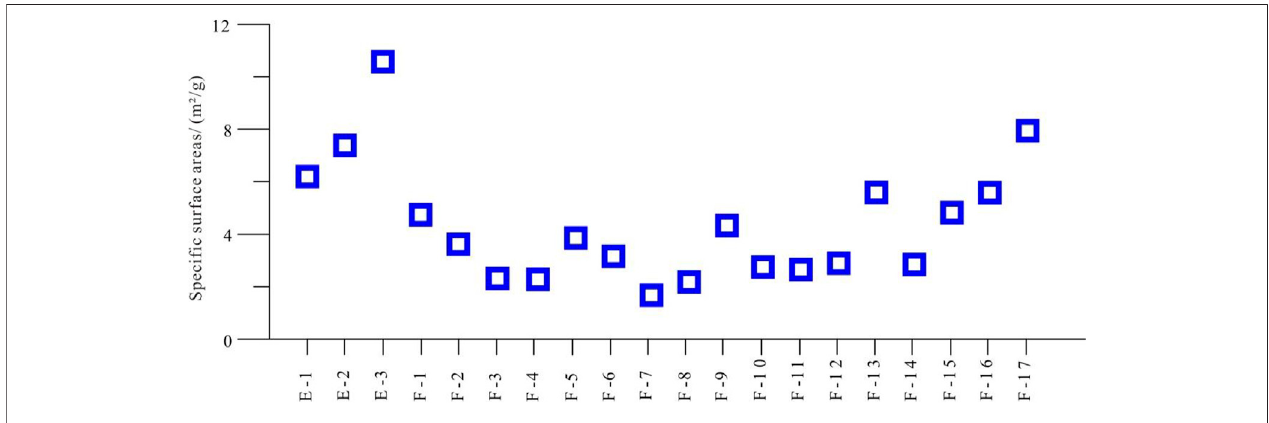
FIGURE 10 | Speci fi c surface area of 20 samples.